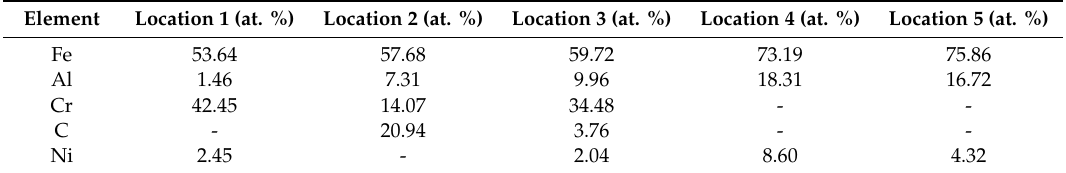
Figure 2. SEM image of alloys grain. A large number of FeCr phases accumulated at the grain boundaries in #1 alloy. In #2 alloy, FeCr phase nucleated on the carbide. There was distribution of FeCr along the grain boundary in 3# alloy. (Ni Fe)Al phase was precipitated in #4 and #5 alloys, which played the role of precipitation strengthening.